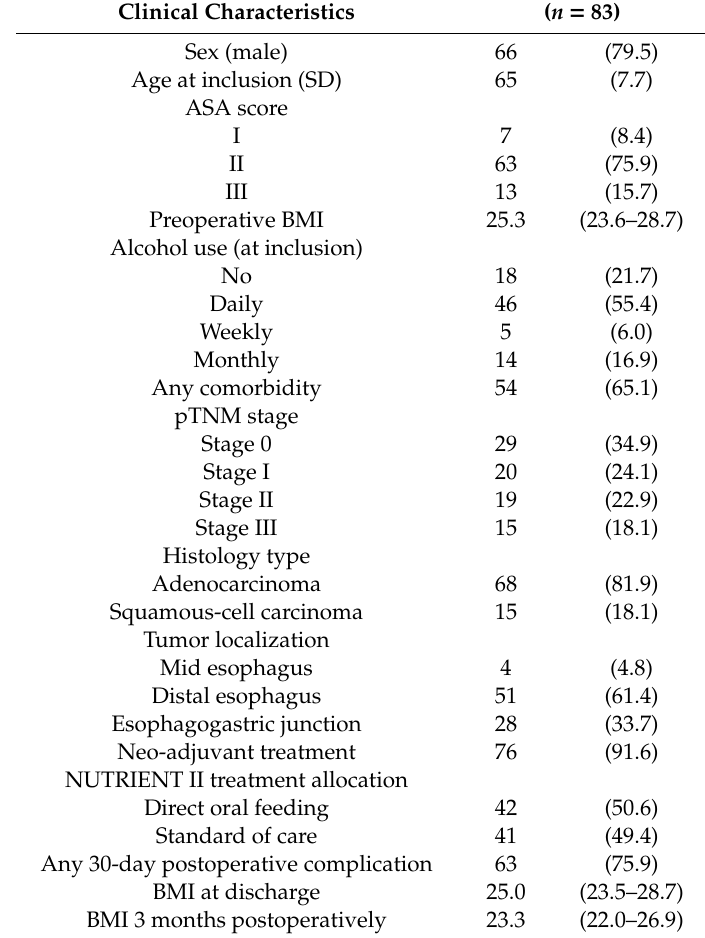
Table 2. Baseline characteristics of study